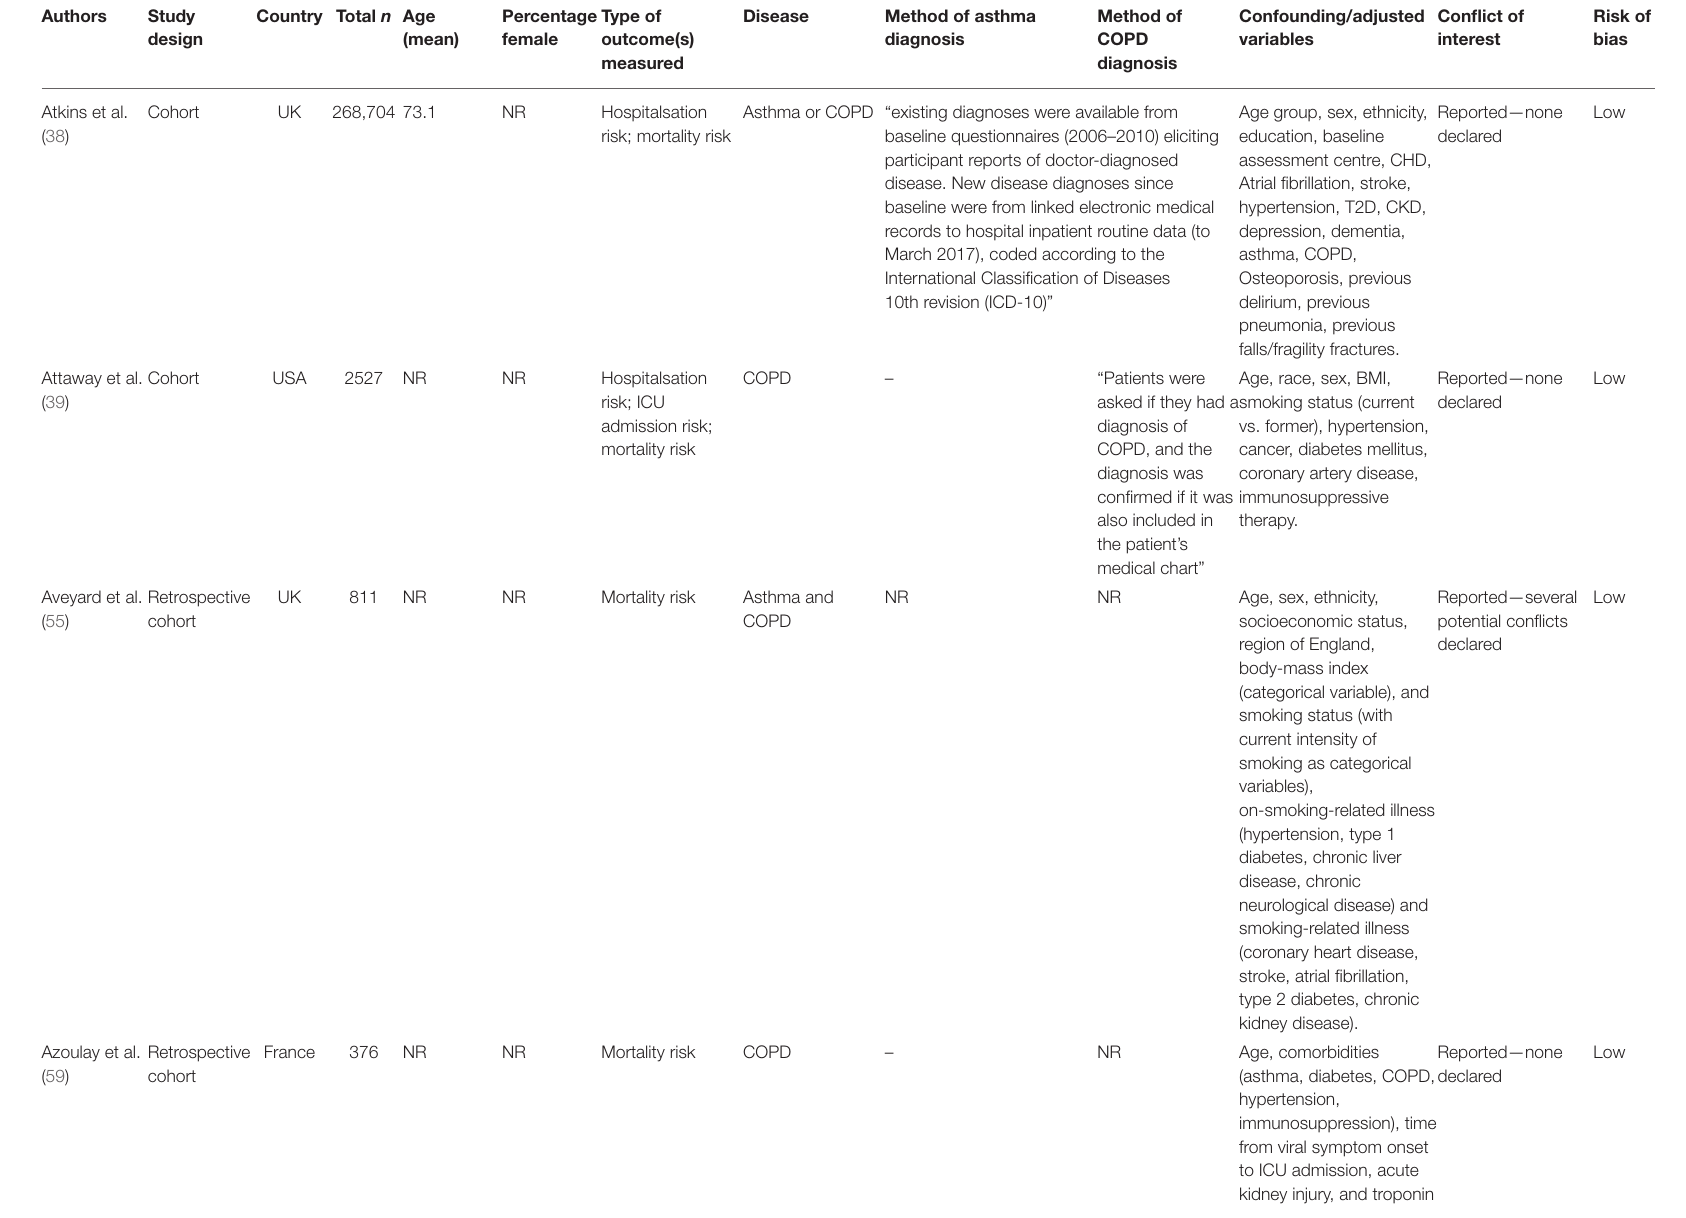
TABLE 1 | Descriptive characteristics of included